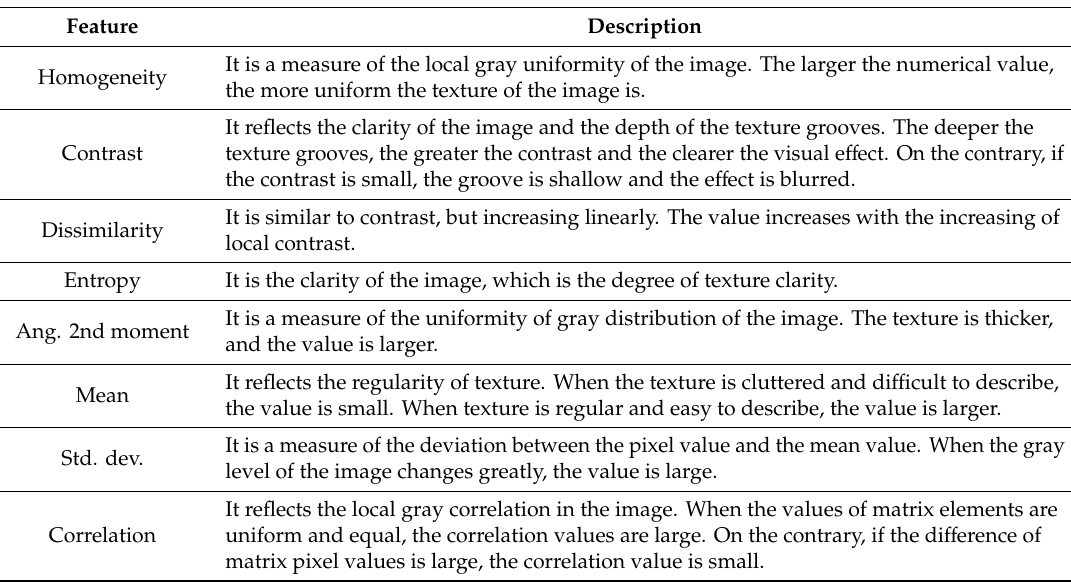
Table 5. Texture feature